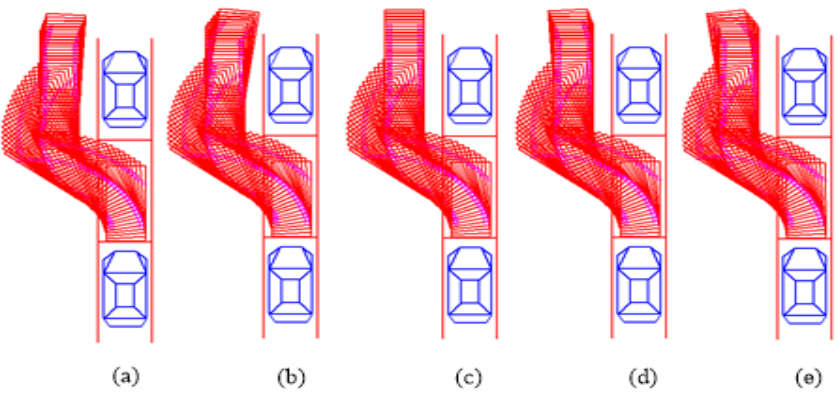
Figure 10. Parking simulation results under nonparallel initial state condition. ( a – e ) respectively are the simulation results of different initial conditions